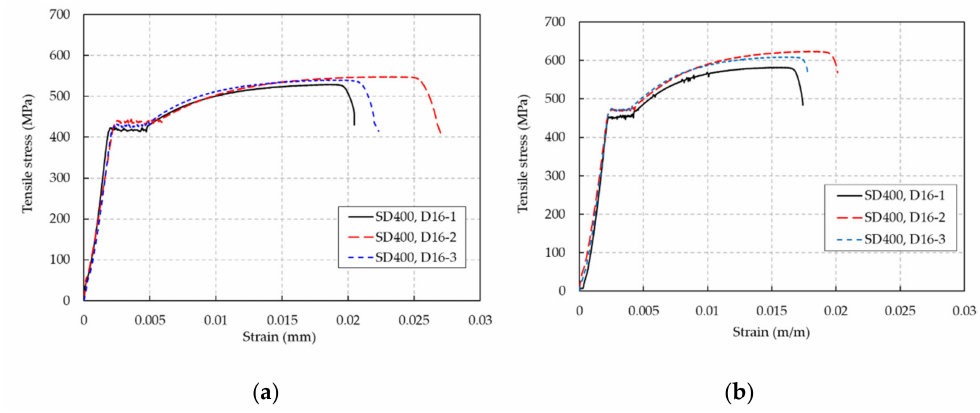
Figure 3. Tension test results of the rebars used. ( a ) Rebars used for the HSC beams, ( b ) rebars used for